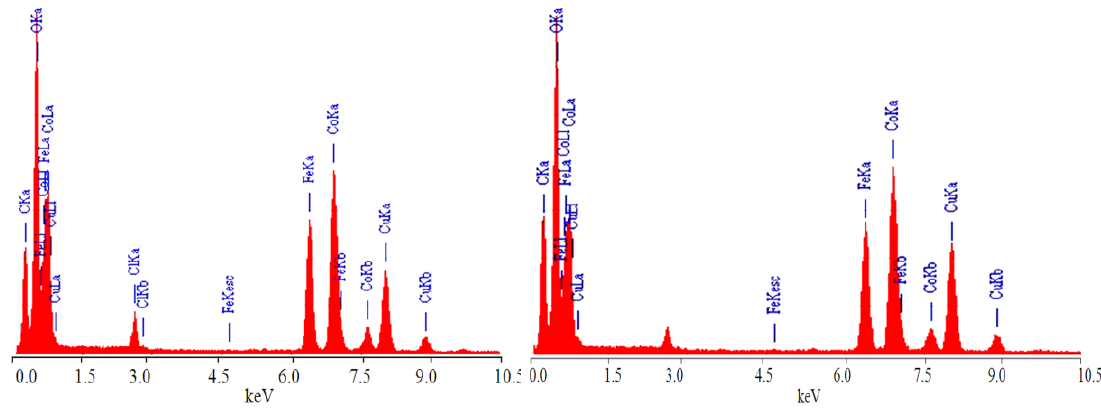
Figure 6. EDX spectra of the CoFe 2 O 4 -supported Co-Fe LDH.